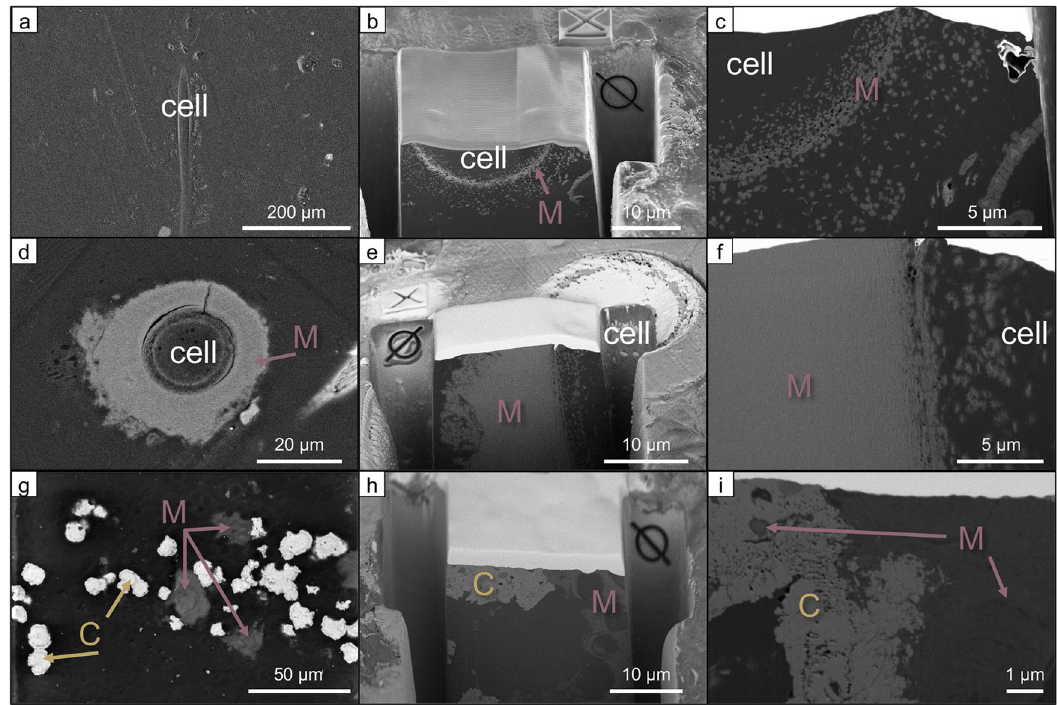
Fig. 4 FIB-SEM nanotomography. Mg-clay (M), Ca – Mn carbonate (C). a – c Orange/brown bulbous mat sample collected from pond P163: a longitudinal section of fi lamentous cyanobacterium with Mg-clay surrounding the cell sheath, b FIB milling area showing the cross section of the cell sheath surrounded by Mg-clay, c Mg-clay nanocrystals form a band around the cell sheath, with a more spaced-out arrangement of rosettes accumulating around the exterior of the cell, and sparse individual nanocrystals at the interior of the cell. Orange gel mat sample collected from Pond P31: d cross section of a fi lamentous cyanobacterium cell with a thick, dense accumulation of Mg-clay surrounding the cell sheath, e FIB milling area, parallel to the cell sheath, f dense Mg-clay aggregation around the cell sheath with nanocrystals rosettes towards the interior of the cell, g Mg-clay throughout an EPS alveolar network in association with Ca – Mn carbonate, h FIB milling area of the carbonate-clay boundary, i detail of the boundary showing inter fi ngering of Mg-clay and carbonate in the upper